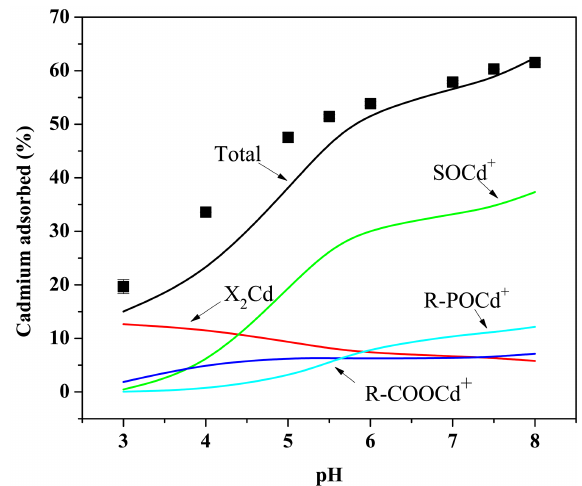
Figure 3. Speciation diagrams for Cd (II) adsorption onto montmorillonite– B. subtilis composite at 28 ◦ C in the presence of 0.01MNaNO 3 , calculated from the surface complexation mod- els (filled squares represent the experimental adsorption data). Cd(II):10ppm, composite: 0.875gL − 1 Mont + 0.125gL − 1 B. subtilis